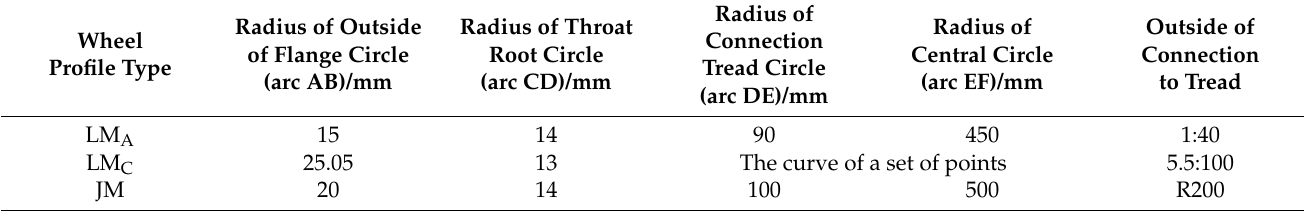
Table 2. The segmented parameters of different wheel profile